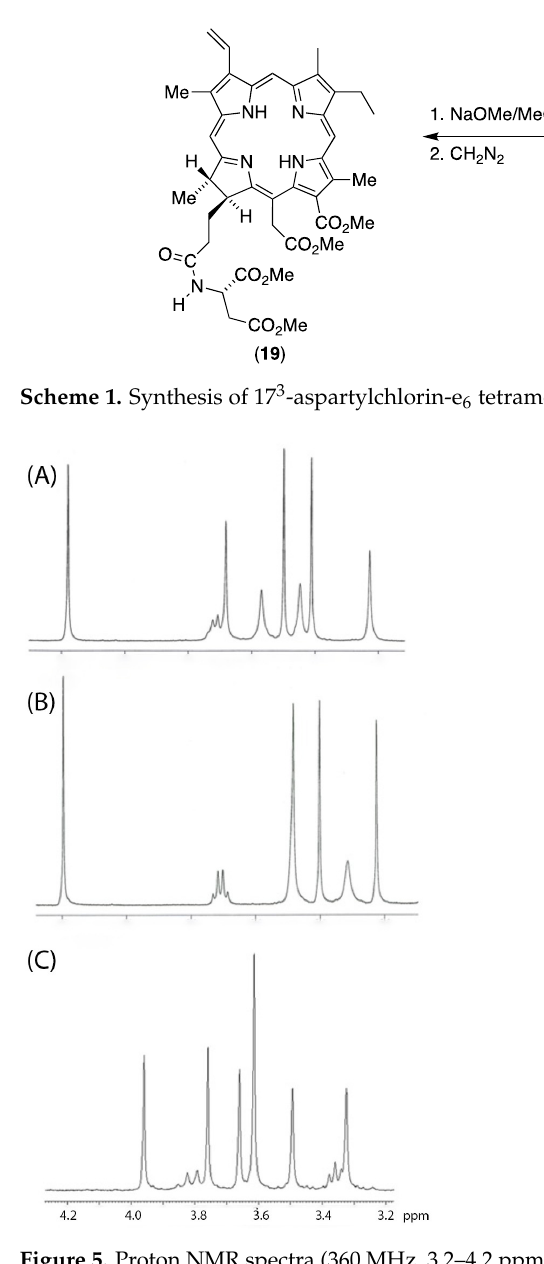
Figure 5. Proton NMR spectra (360 MHz, 3.2–4.2 ppm region, in CDCl 3 ) of ( A ) 17 3 -aspartylchlorin-e 6 tetramethyl ester ( 19 ), ( B ) authentic NPe6 tetramethyl ester (15 2 regioisomer, ( 23 )), and ( C ) 13 1 - aspartylchlorin-e 6 tetramethyl ester ( 22 ). The signals at ~4.2 ppm in ( A , B ) correspond to the methyl ester of the 13 1 substituent.